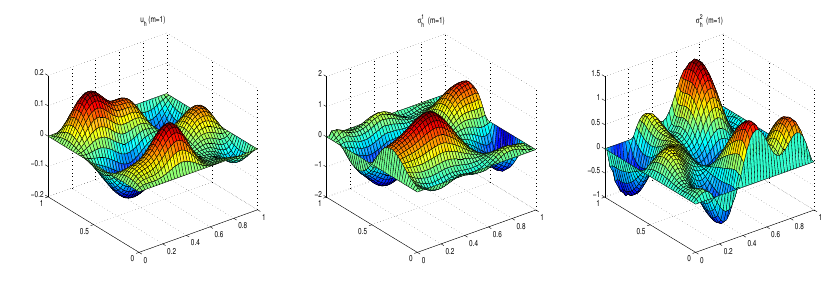
Figure 3. Numerical results by Parallel algorithm, m = 1.